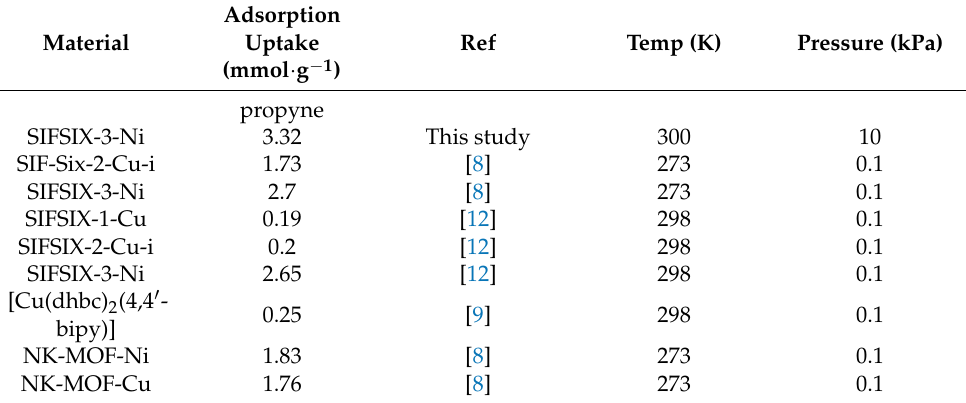
Table 2. Reported uptake values of propyne and propylene on metal-organic frameworks